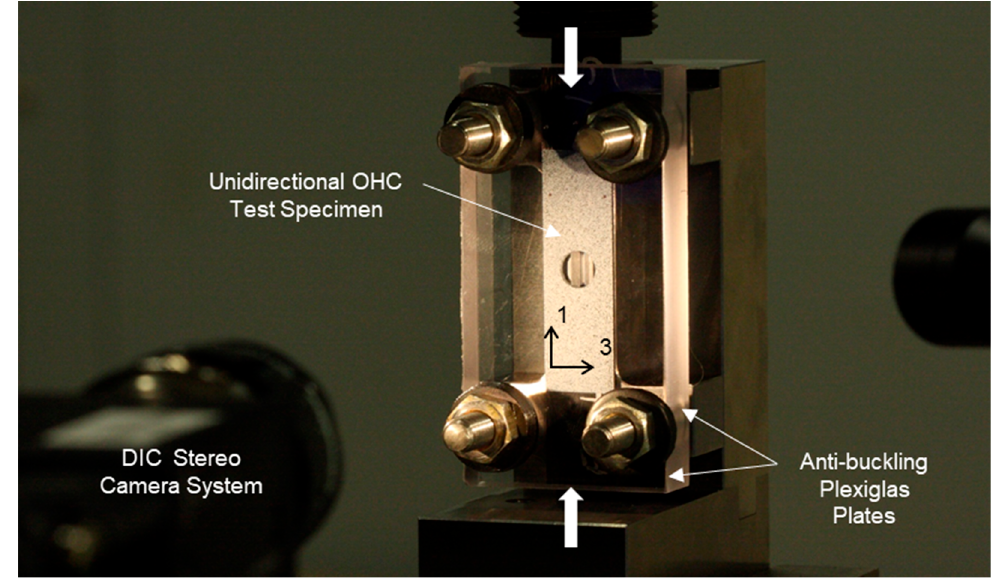
Figure 2. A test setup for measurement of interlaminar tensile (ILT) strength in a unidirectional OHC test specimen.